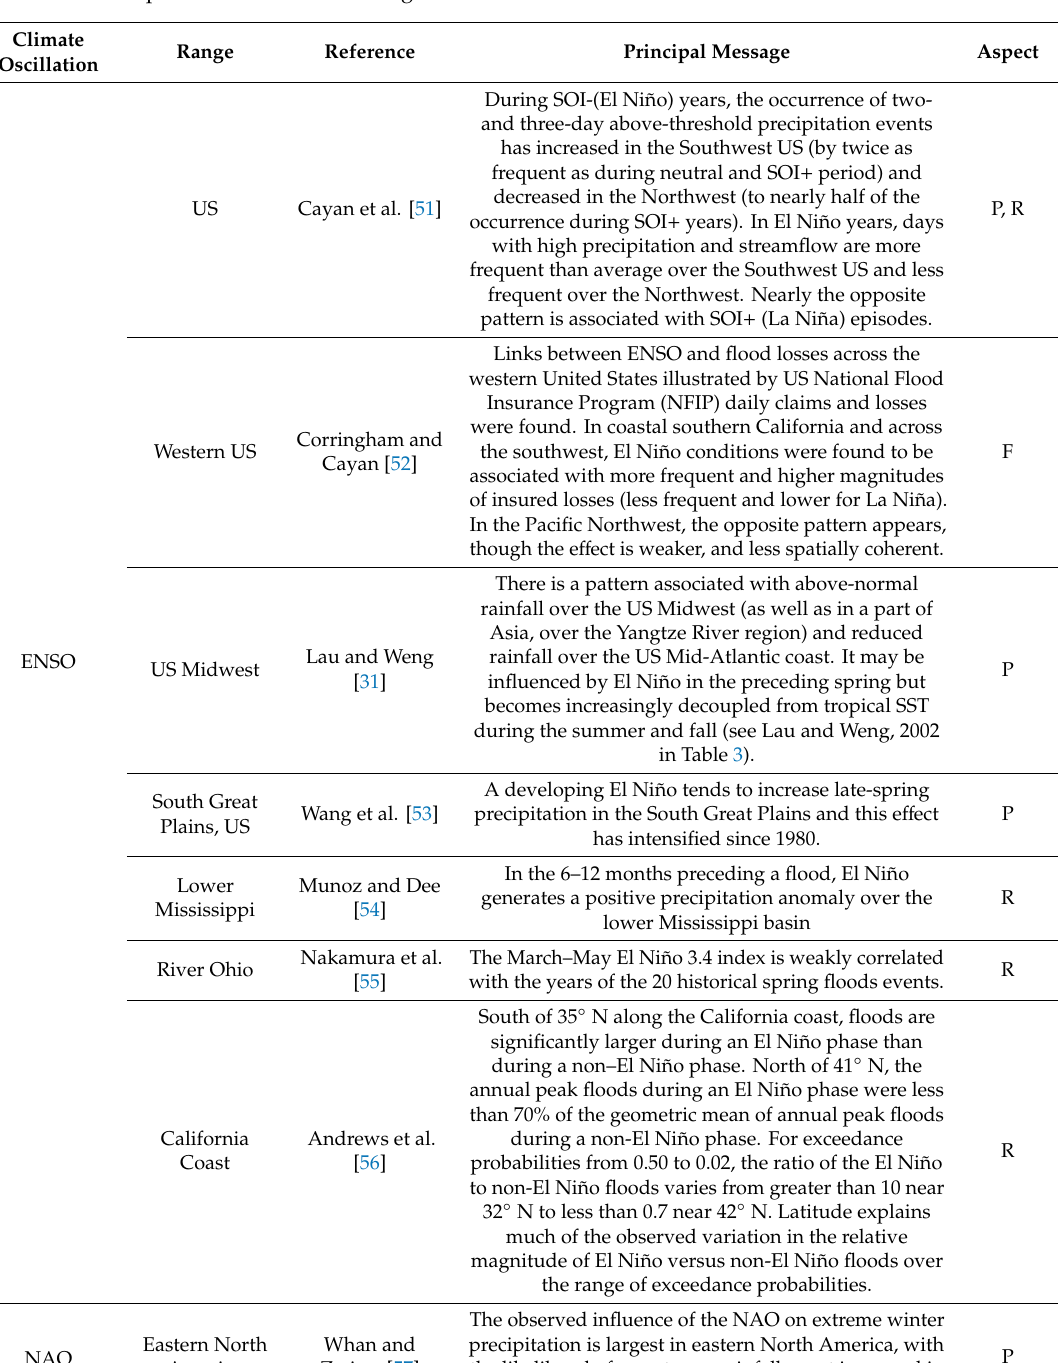
Table 4. Review of links between climate oscillation and floods for North America, as reported in the literature. Aspects of reference in the rightmost column—as in Table